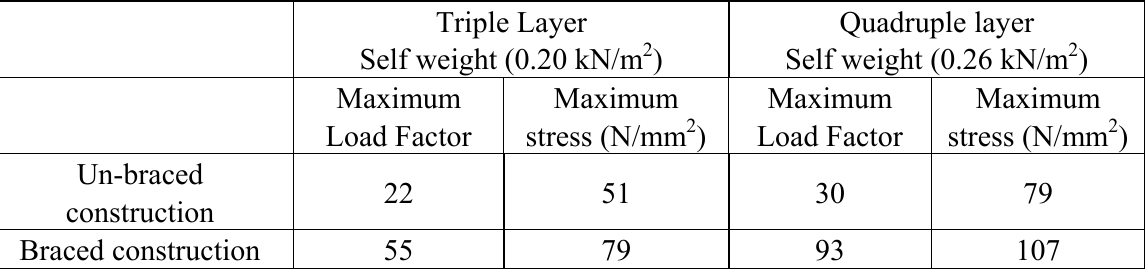
Table 2. Ultimate funicular load and maximum